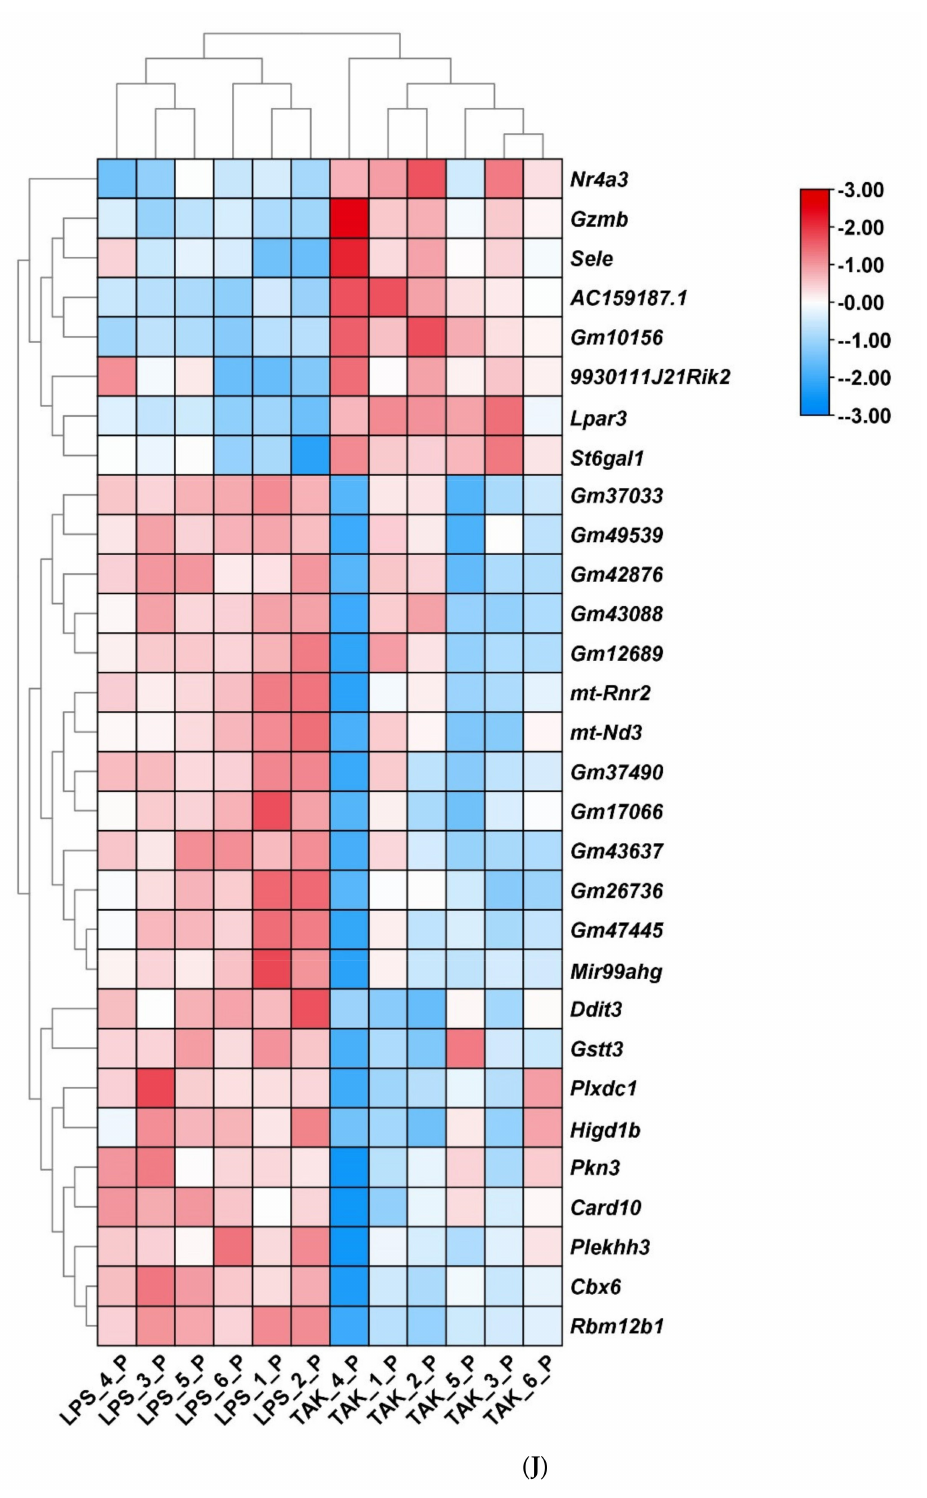
Figure 3. Basic information of RNA-seq detection. ( A , B ) The boxplot ( A ) and ( B ) Violin plot gene expression. ( C , D ) The proportion of the differentiated expressed genes (DEGs) in group 1 (LPS vs. Control) ( C ) and group 2 (TAK vs. LPS) ( D ). ( E , F ) Volcano plots of RNA-seq results in group 1 (LPS vs. Control) ( E ) and group 2 (TAK vs. LPS) ( F ) (green dots, down-regulated genes; red dots, up-regulated genes). ( G ) Statistics of DEGs (those genes that cannot be annotated were removed). ( H ) Venn plot of DEGs. ( I , J ) Heat map of the DEGs in group 1 (LPS vs. Control) ( I ) and group 2 (TAK vs. LPS) ( J ). In addition, the 30 genes with the most significant changes in the up-regulated and down-regulated groups were shown